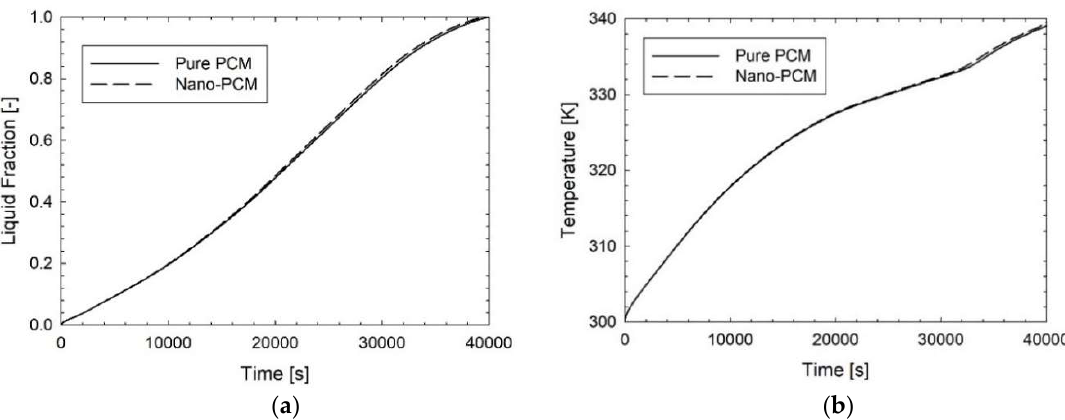
Figure 2. Comparison of pure PCM and nano-PCM at 1% during the time in terms of ( a ) average liquid fraction and ( b ) average temperature evolution.